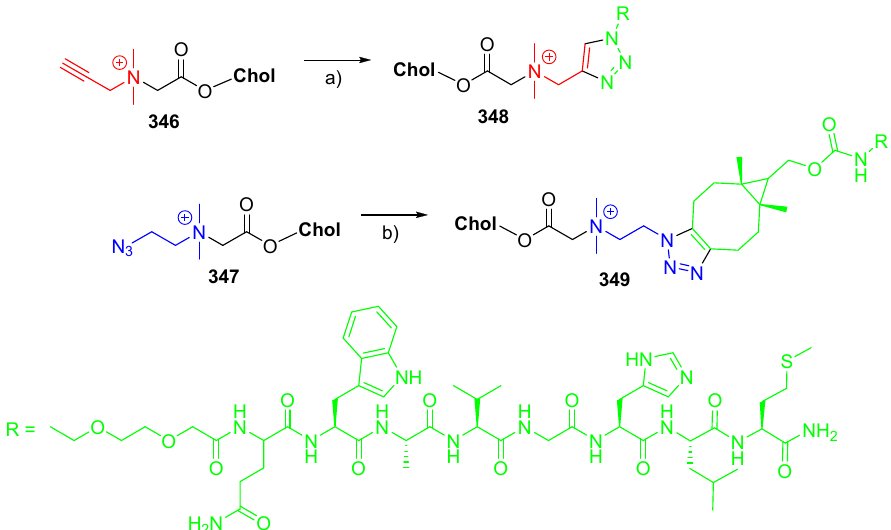
Scheme 84. Synthesis of bombesin (BBN)-cholesterol conjugates. Reagents and conditions: a ) N